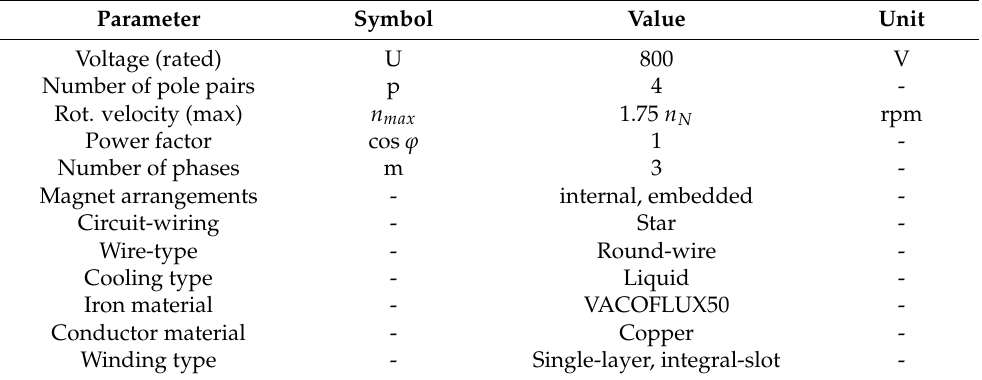
Table 2. Assumptions of input parameters for the machine design tool MEAPA (Note: rpm: revolu- tions per